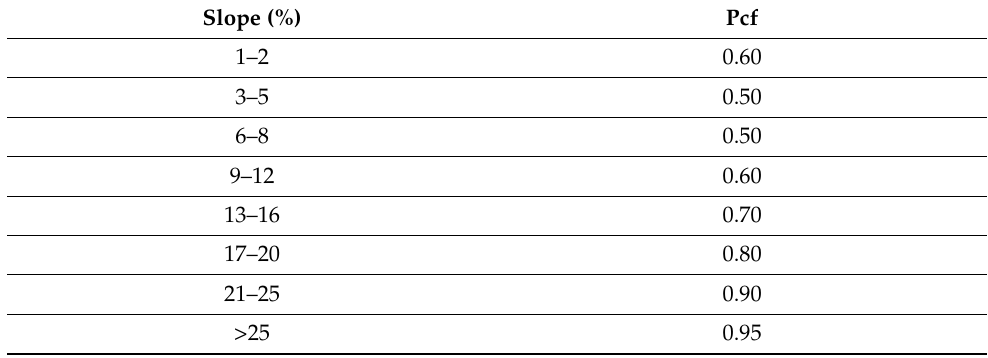
Table 5. P-factor values for contour farming practices for different slope gradients [19].